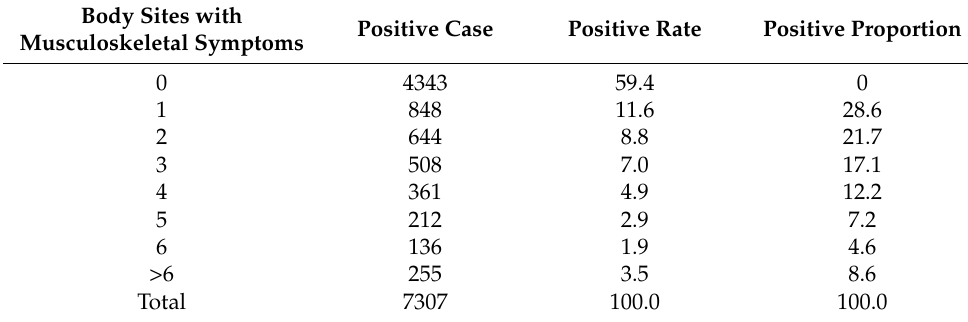
Table 2. Prevalence of multi-site musculoskeletal symptoms in the past 12 months. Body Sites